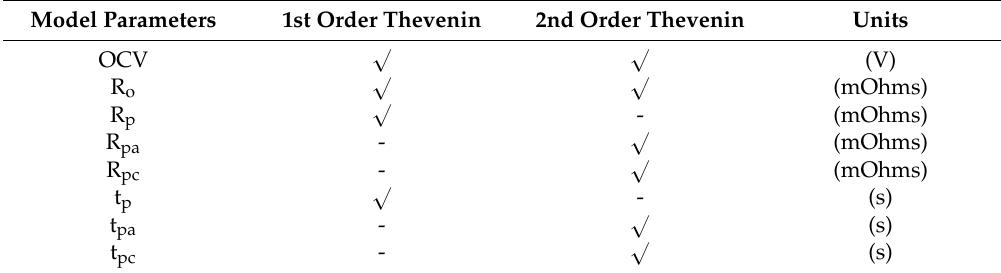
Table 3. List of parameters for 1st and 2nd order Thevenin Models. OCV: open circuit voltage; R o